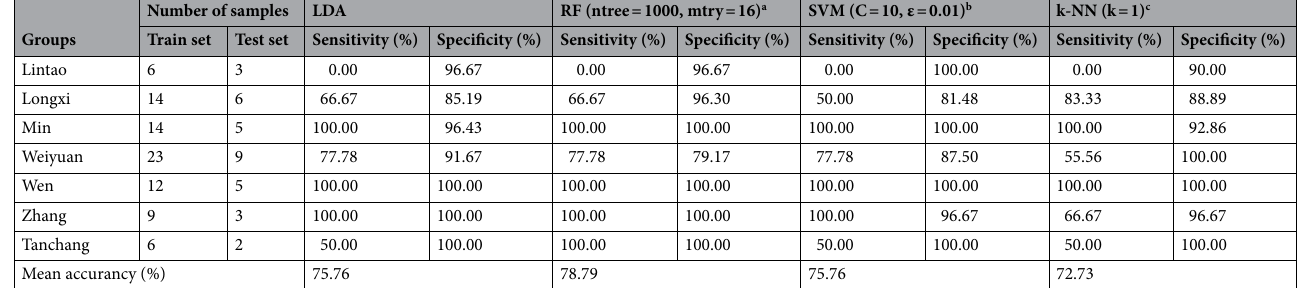
Table 4. Discrimination results obtained with the different chemometrics models. a ntree number of trees, mtry number of variables tried at each split. b C penalty factor, ε ε-insensitive loss function. c k number of k